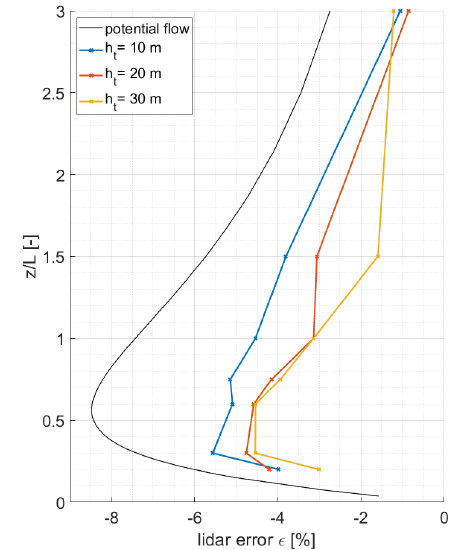
Figure 12. Lidar error ε in dependence of atmospheric stability between z/L ratios from 0 to 3. Results are based on Meteodyn WT (coloured) and the potential flow model (black) for an H/L ratio of 0.3. Results are shown for the forested case with a tree height h t = 20m and medium forest